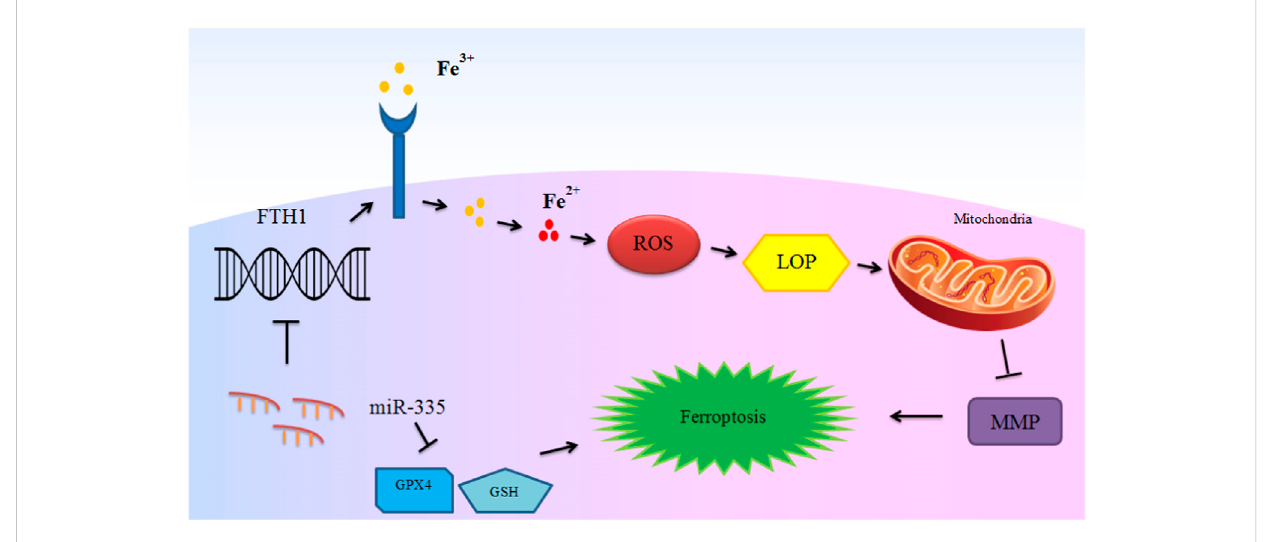
The mechanism of ferroptosis induction in Parkinson ’ s disease by miR-335. miR-335 targets FTH1 and degrades it to promote iron release, lipid peroxidationandreactiveoxygenspecies (ROS)accumulation, anddecreases mitochondrial membranepotential (MMP) andintensify ferroptosis andPD pathology.Althoughglutathioneperoxidase4(GPX4)isnotdirectlytargetedbymiR-335,up-regulationofmiR-335alsoleadstoreductionofthelevelsof this ferroptosis marker protein (Li X. et al.,